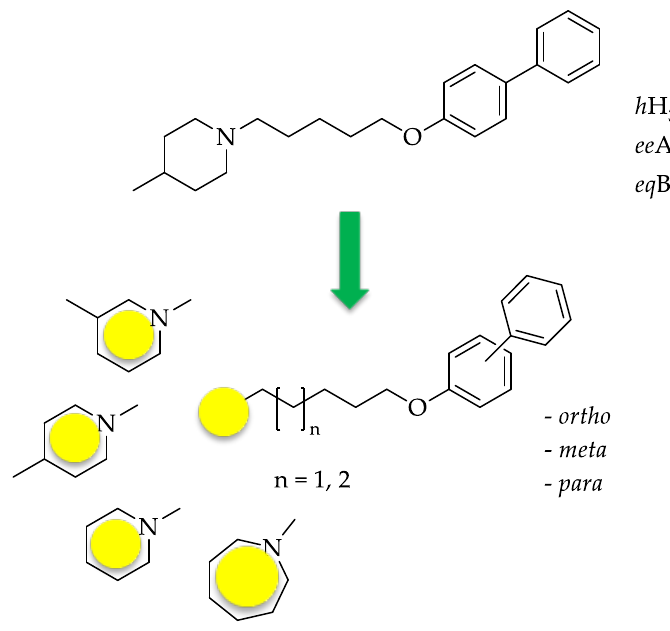
Table 1. Structures and biological activities of tested compounds.